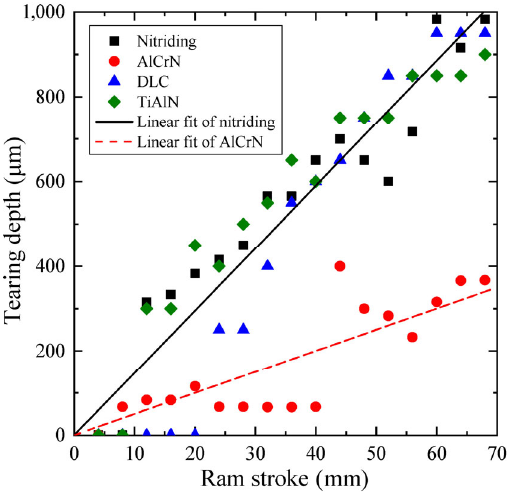
Fig. 13 Tearing size–stroke diagram of each die with different coatings (billet temperature: 450 °C, ram speed: 1.0 mm/s)